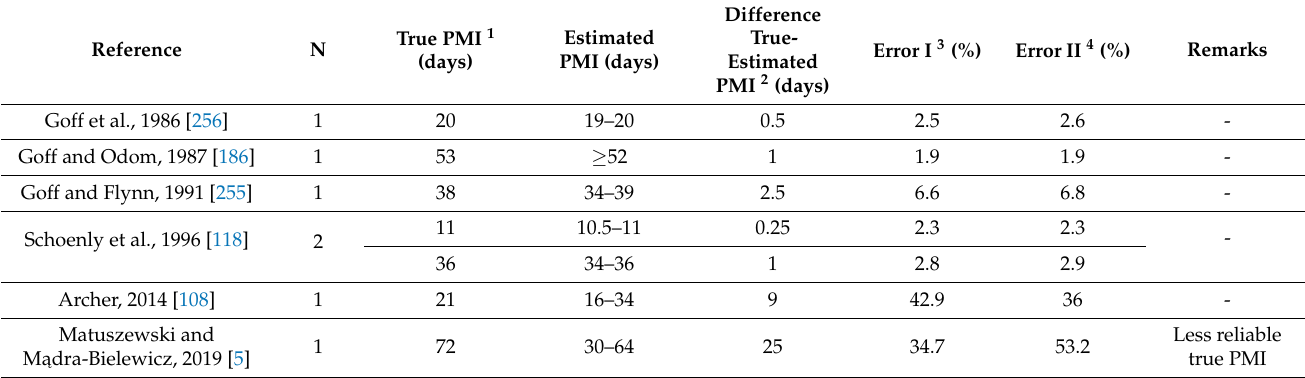
Table 6. Errors of the protocols for the estimation of PMI based on insect